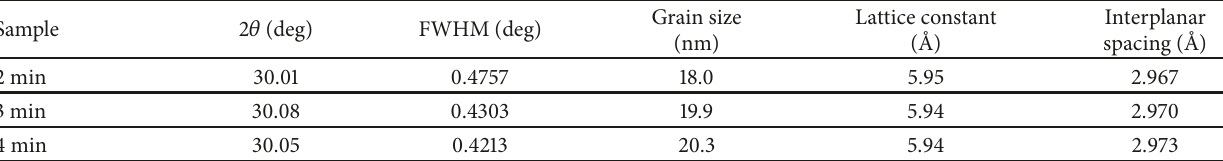
Table 1: Structural parameters as a function of deposition time.